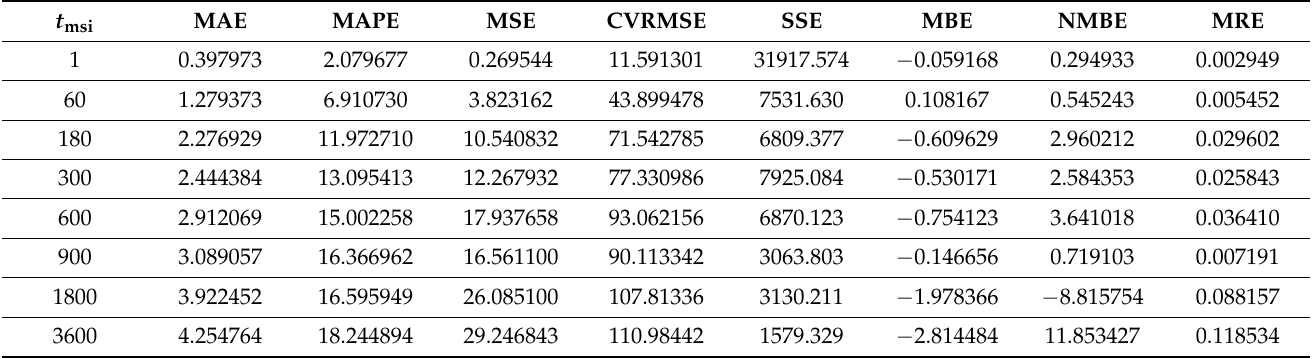
Table 3. Calculated error metrics for various multistep time intervals ( t msi ) in test